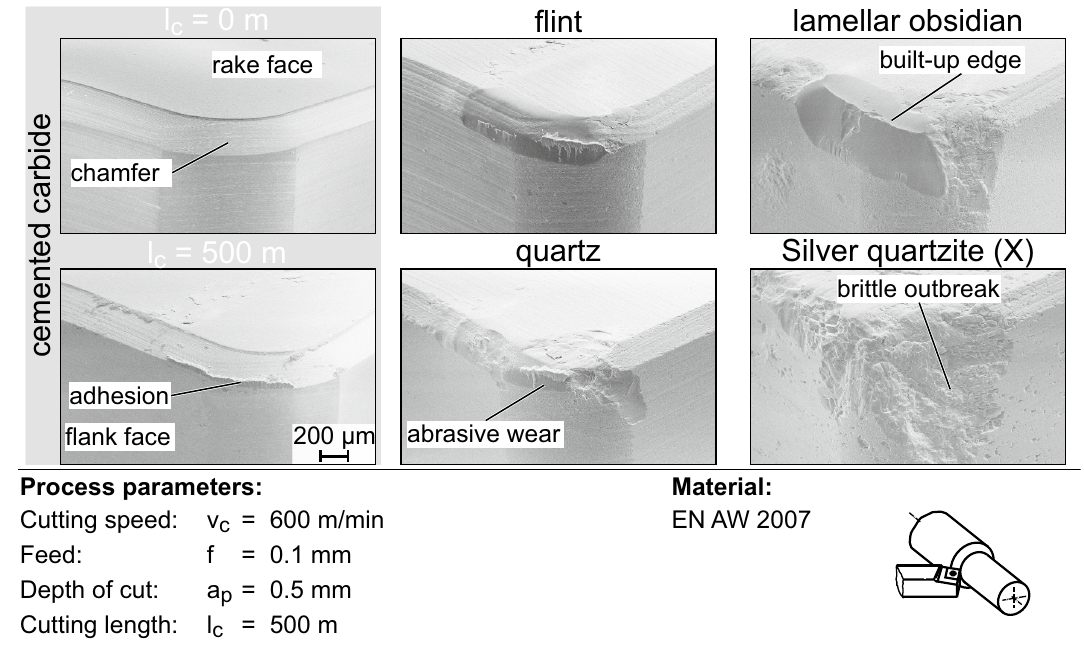
Fig. 15 SEM-images of wear of different rock inserts after turning aluminium compared to a cemented carbide tool